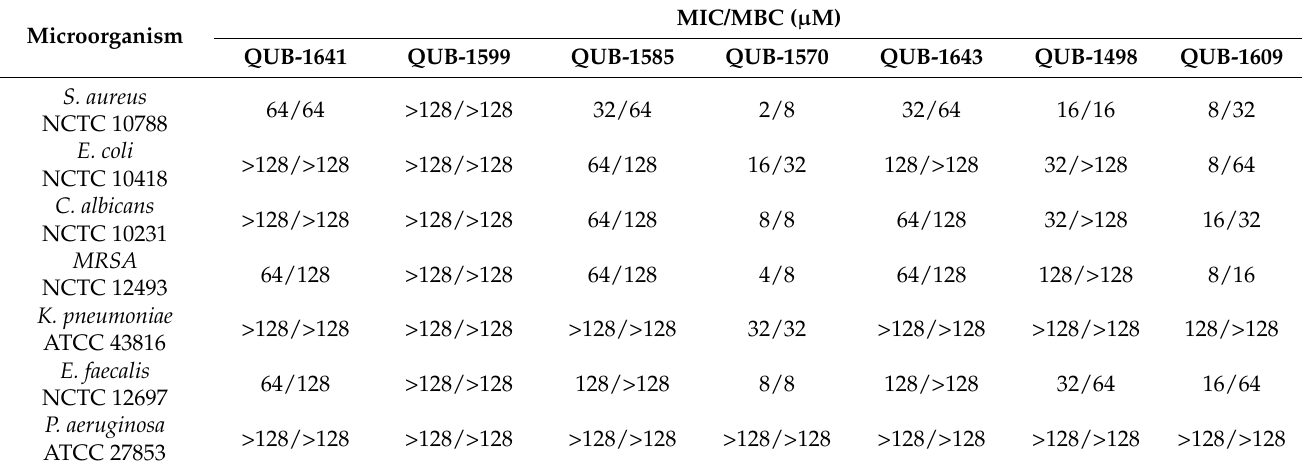
Table 3. MICs and MBCs of kassporin-KS1 (QUB-1641) and its analogues. Microorganism